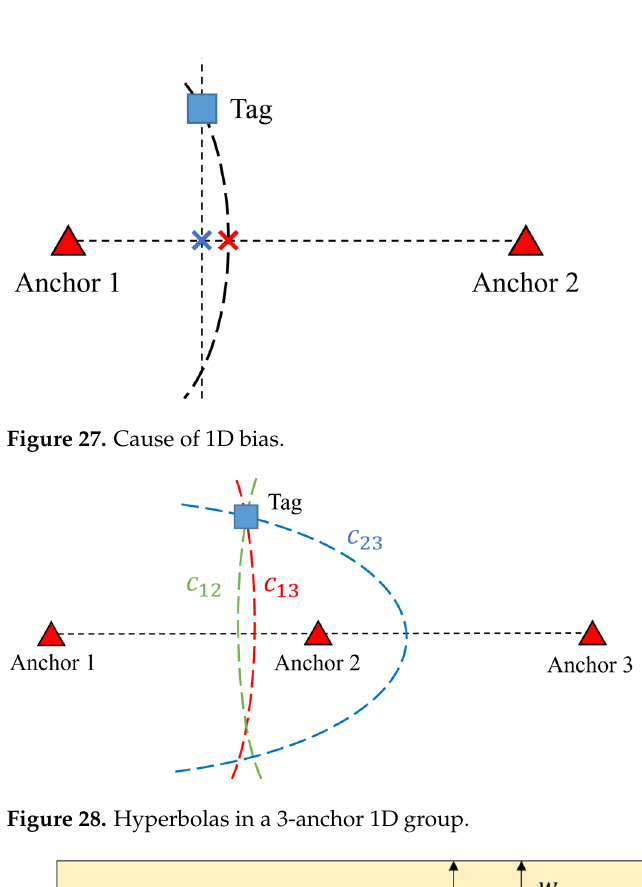
Figure 27. Cause of 1D bias.